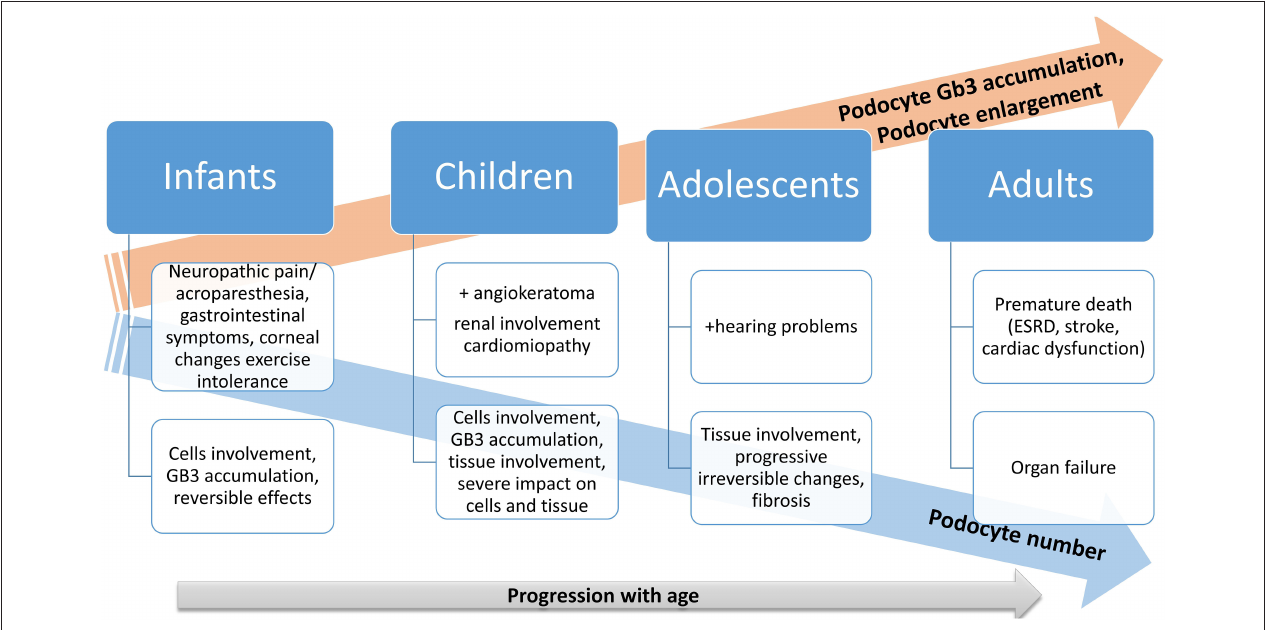
FIGURE 1 | Progression of Fabry disease: a schematic illustration.